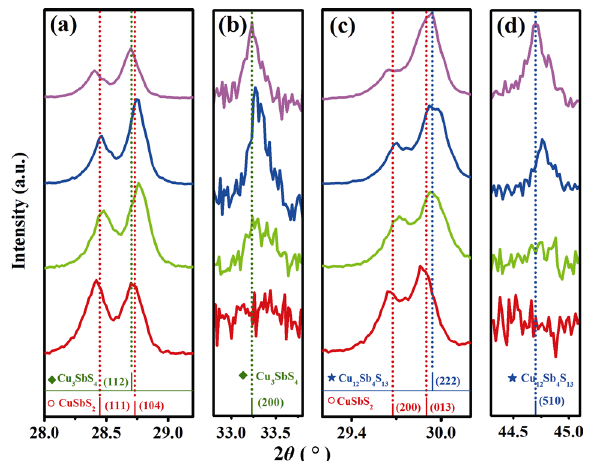
(2) indicates the formation of Cu Sb S . The substitution of Sb 3+ by Cu + and/or Cu 12 4 13 Cu 2+ in Eqs. (3) and (4) would introduce one